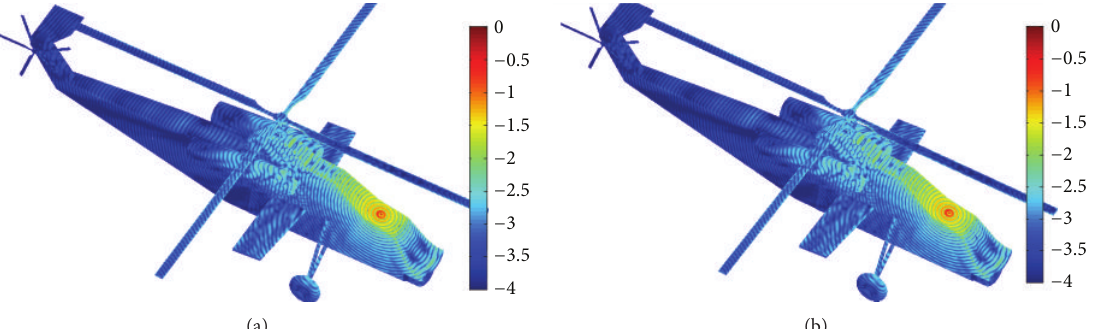
Figure 10: The surface current distribution of the monopole antenna on helicopter evaluated by the HS-DDM (a) and MLFMA (b) (logarithmic scale).